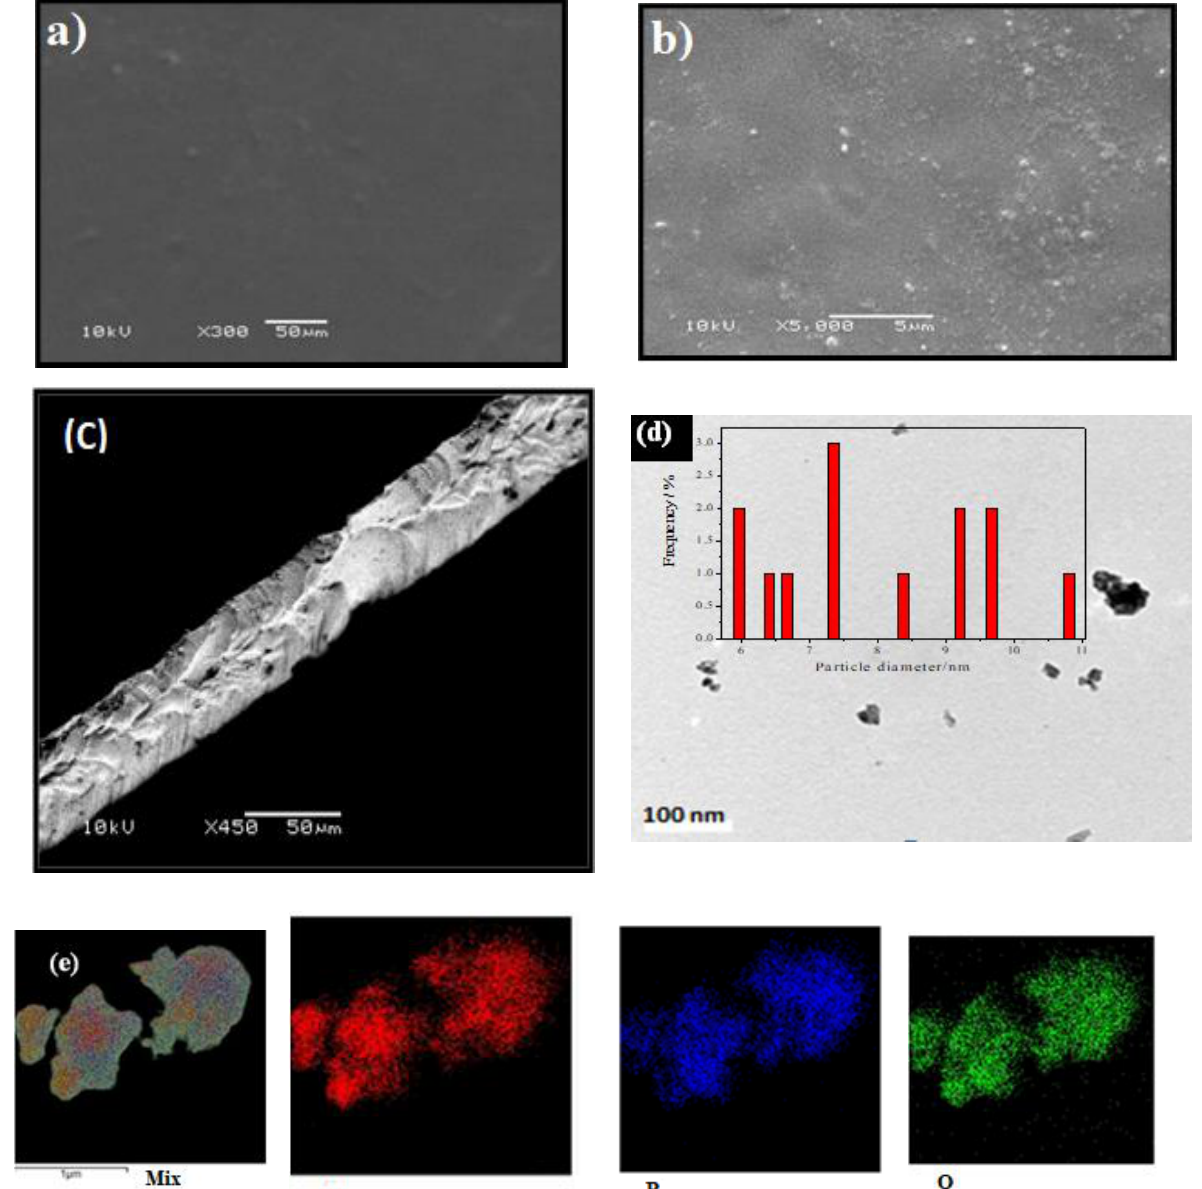
Figure 4. SEM images of ( a ) undoped surface, ( b ) IC/PVA/ZrPO 4 -7.5 surface, ( c ) cross-section of IC/PVA/ZrPO 4 -7.5, ( d ) TEM image of nano zirconium phosphate, and ( e ) EDX mapping of nano zirconium phosphate .